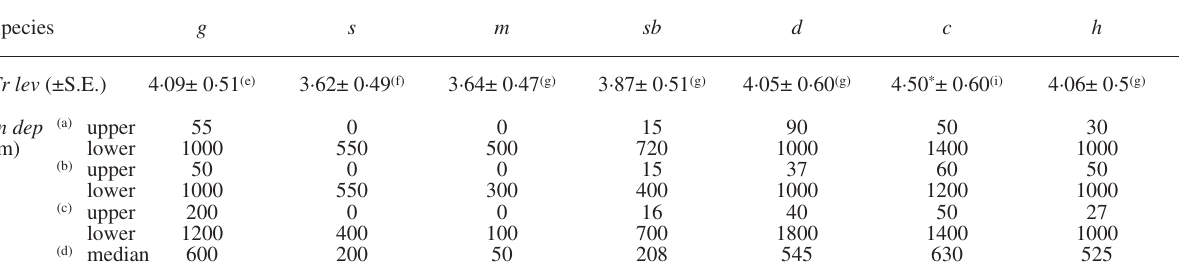
Table 1. – Upper, median and lower depth limits ( In dep ) and mean trophic level ( Tr lev ) for Galeus melastomus ( g ), Sciliorhinus canicula ( s ), Mustelus asterias ( m ), Heptranchias perlo ( h ), Squalus blainvillei ( sb ), Dalatias licha ( d ) and Centrophorus uyato ( c ). mediterranean depth limits for studied species are obtained from Fischer et al ., 1987 (a), notarbartolo di Sciara and bianchi, 1998 (b) and Serena, 2005 (c). the median was extrapolated in the present paper (d). trophic levels with standard error (S. e.) for studied species were obtained from data available on www.fishbase.org, version (10/07) (data extrapolated for the unfished population of the original samples of carasson et al. 1992 (e), ellis et al. 1996 (f), cortès, 1999 (g) and compagno, 1984 (i). Species g s m sb d c h Tr lev (±S.e.) In dep (a) upper 50